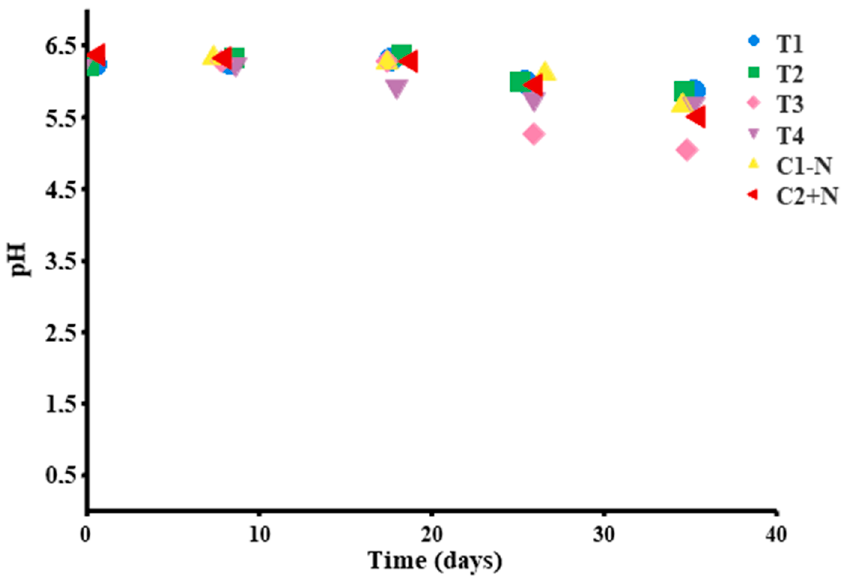
Figure 7. pH monitoring for biopreserved chorizo treatments T1–T4 and